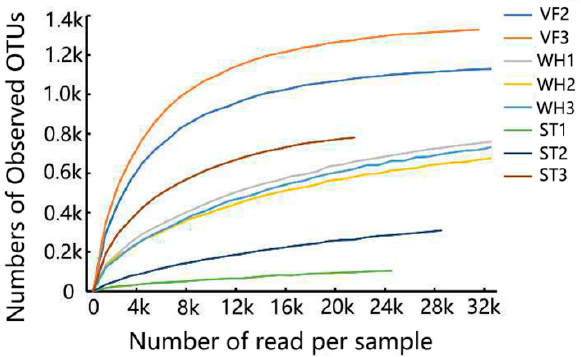
Figure 2. Rarefaction curve of VF, WH, and ST.